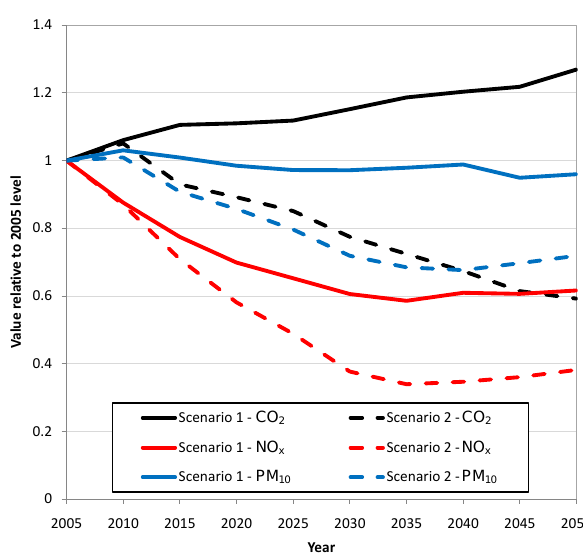
FIG 5 Fig. 5. Changes in national emissions of CO 2 , NO x and PM 10 , relative to 2005, for Scenarios 1 and 2. Formatted for color repro- duction